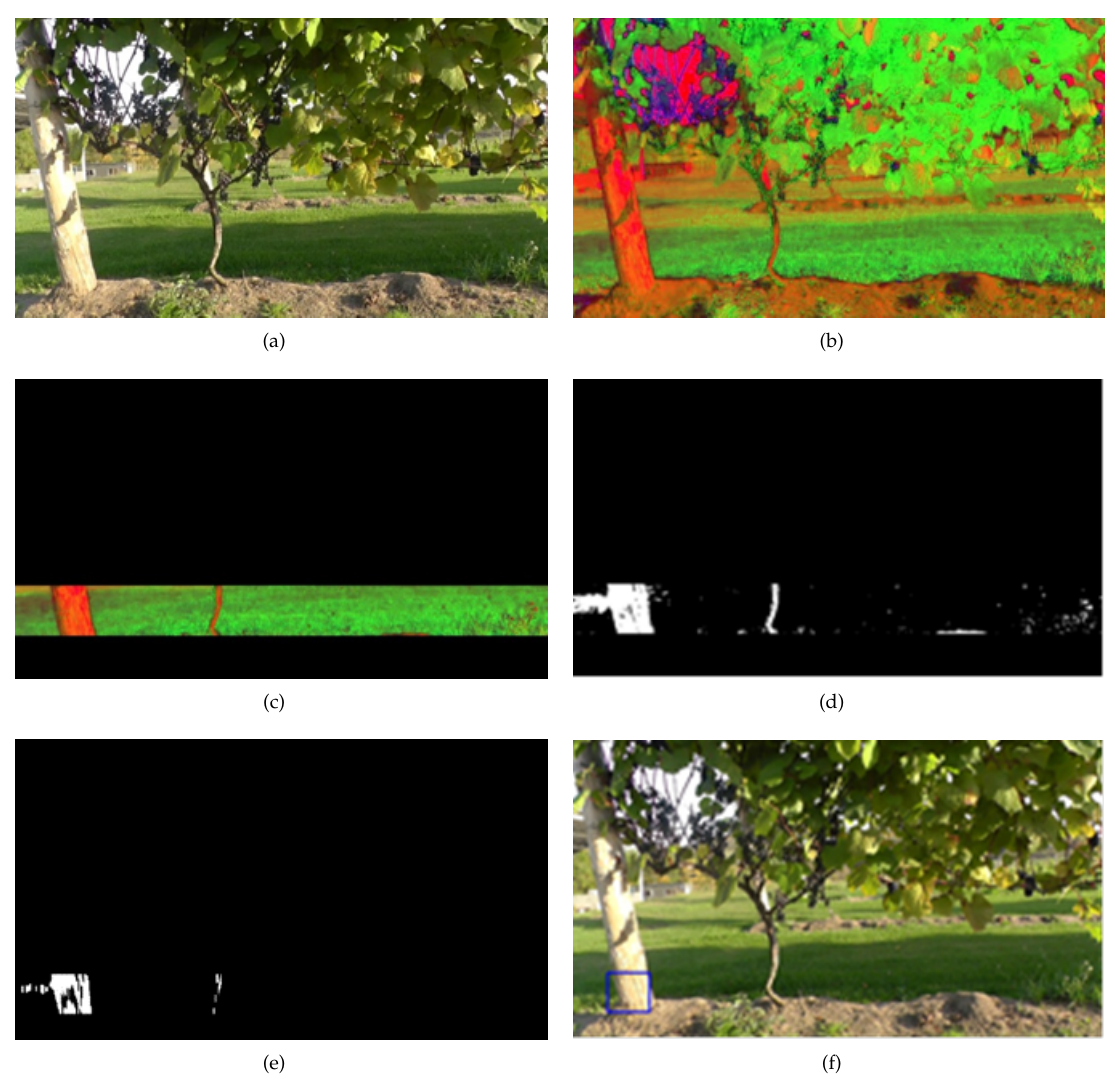
Figure 4. Pillar detection in vineyard: ( a ) input RGB image; ( b ) image I hsv in HSV colorspace; ( c ) Masked image; ( d ) binary image I b after color search between upper _ range and lower _ range ; ( e ) image I b with noise removed after erode and dilate operations; and ( f ) pillar detected after finding contours and checking parameters. Detection is shown as a blue